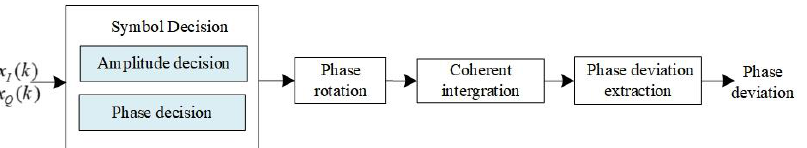
Figure 2. Block diagram of carrier phase deviation discriminator of the conventional decision-feedback loop.